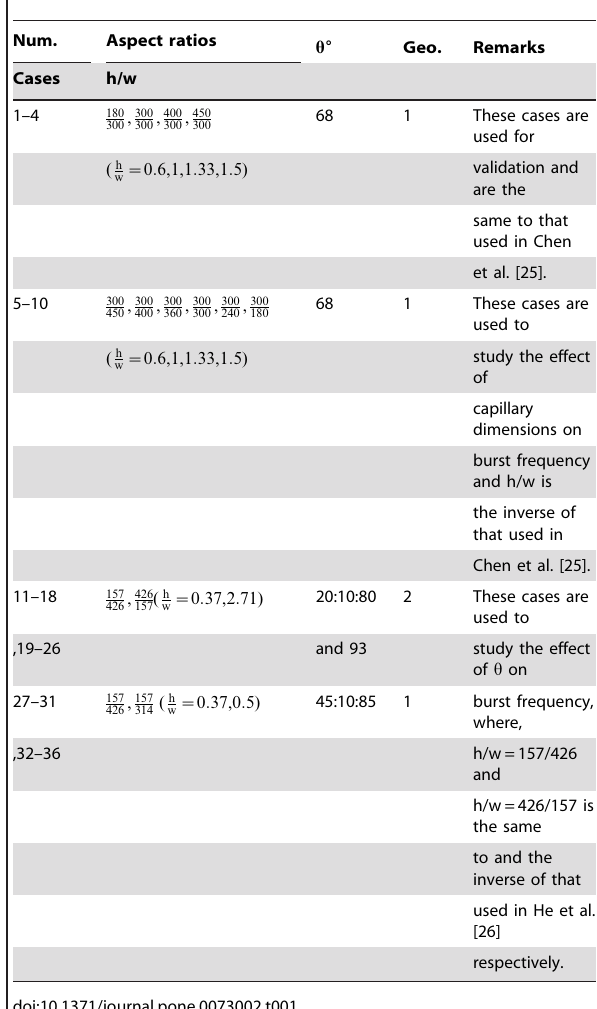
Table 1. Details of simulation Cases